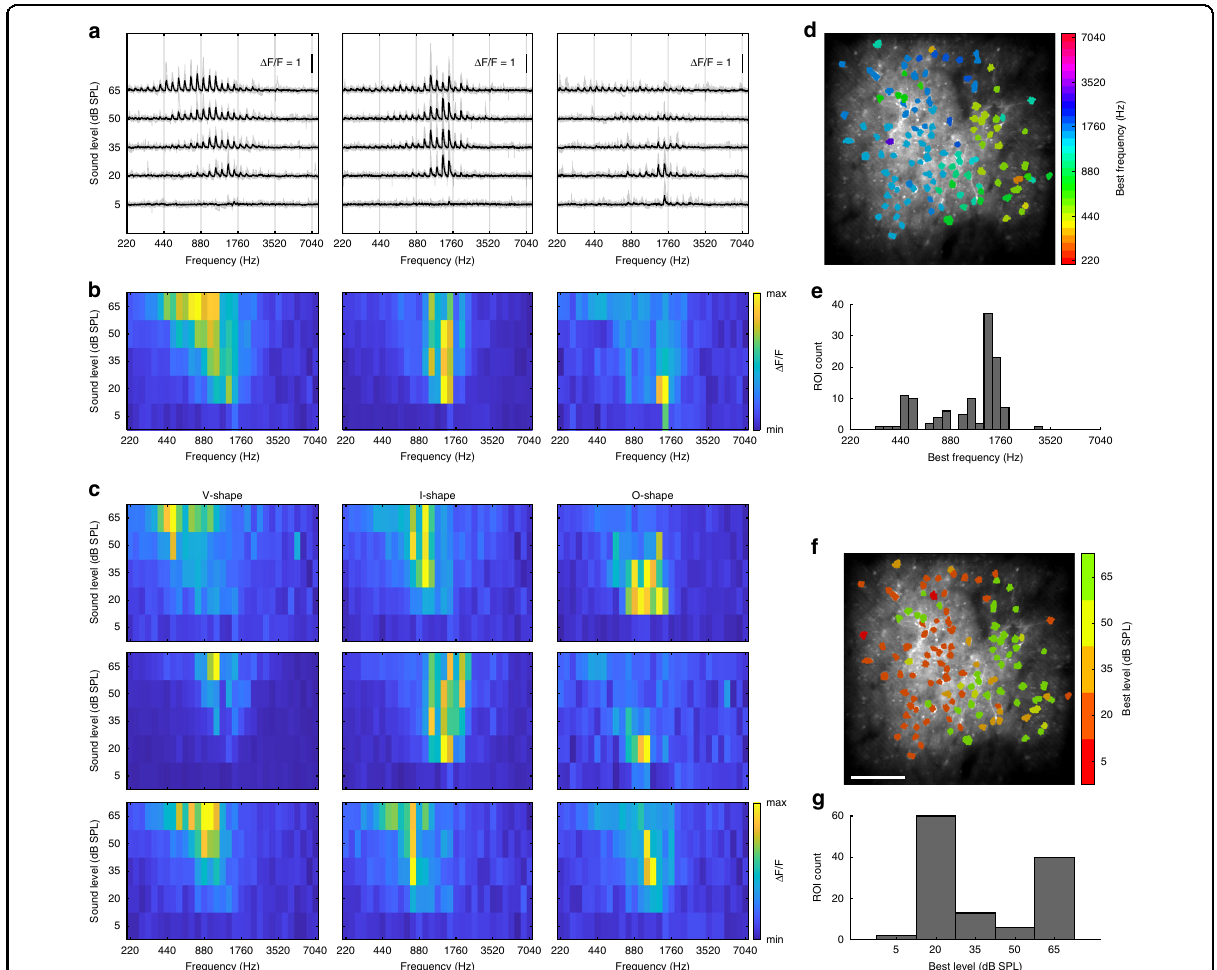
Fig. 4 Receptive fi eld mapping in auditory neurons with coverage of low sound levels. a Calcium traces of three exemplar neurons. Trials vary in pure-tone stimulus frequency and level. The experiment covers sound levels down to 5 dB SPL. Solid black lines: mean responses ( n = 10 repetitions); light gray lines: responses of individual trials. b The FRA (frequency responsive area) summarized from the calcium responses in ( a ). These exemplar neurons show FRAs with the characteristic types of V-shape, I-shape, and O-shape. c More exemplar FRAs of these characteristic types from nine additional neurons. Among these exemplar FRAs. Clear responses at the sound level of 20 dB SPL are common. d The topography of neurons in the FOV labeled with their best frequencies (BFs). e The histogram of BF distribution. f The topography of neurons in the FOV labeled with their best levels (BLs). Scale bar: 100 μ m. g The histogram of BL